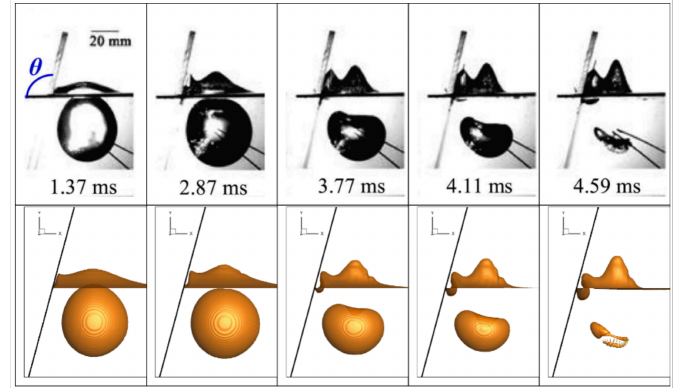
Figure 7. Visual comparison of bubble burst near the wall.